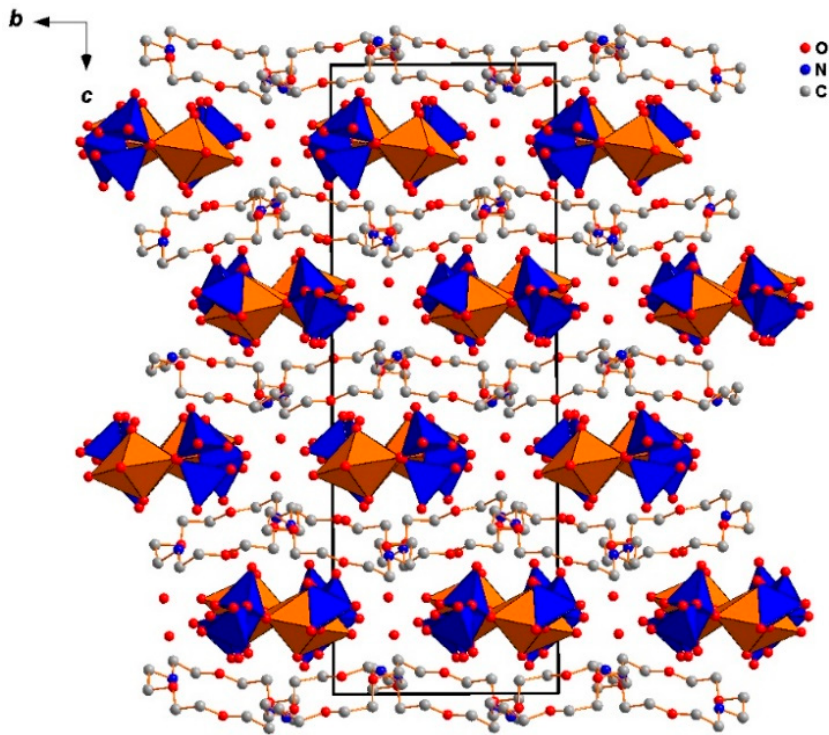
Figure 1. General projection of the crystal structure of 1 along the a -axis (designations: UO 7 = orange; CrO 4 = blue). Pseudolayers formed by [(UO 2 ) 2 (Cr 2 O 7 ) 4 (H 2 O) 2 ] 4 − units and water molecules alternate